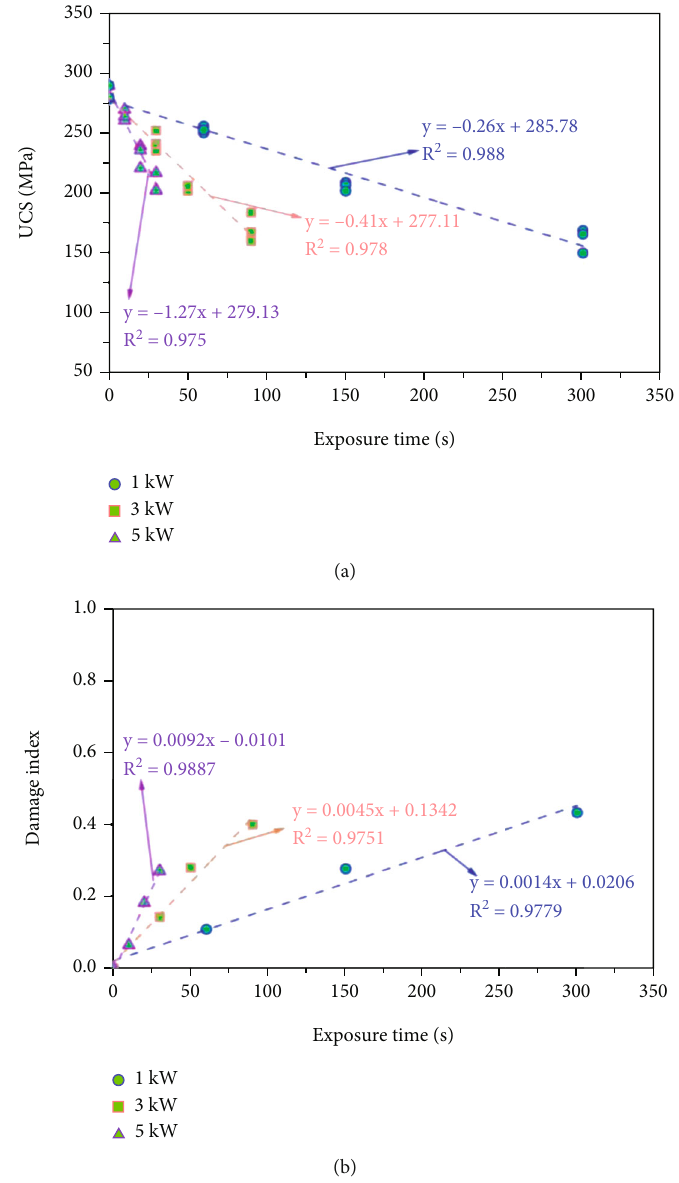
Figure 8: Variation of UCS: (a) UCS of the basalts and (b) damage index based on the